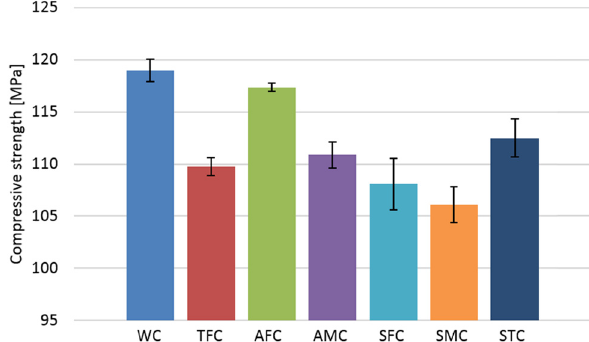
Figure 8: Results for splitting tensile strength.